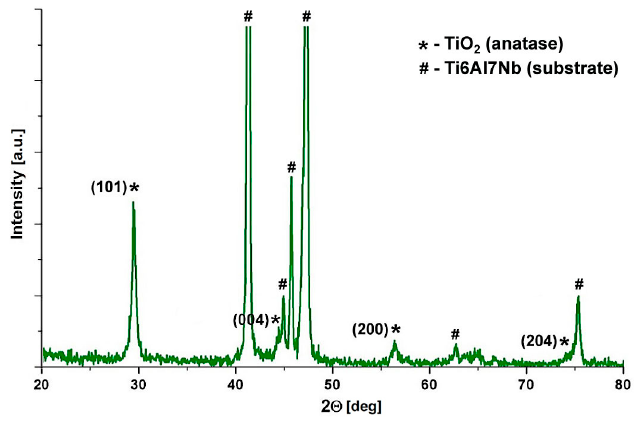
Figure 5. Di ff raction pattern of TiO 2 coating deposited on a Ti6Al7Nb alloy Figure 5. Diffraction pattern of TiO 2 coating deposited on a Ti6Al7Nb alloy substrate.